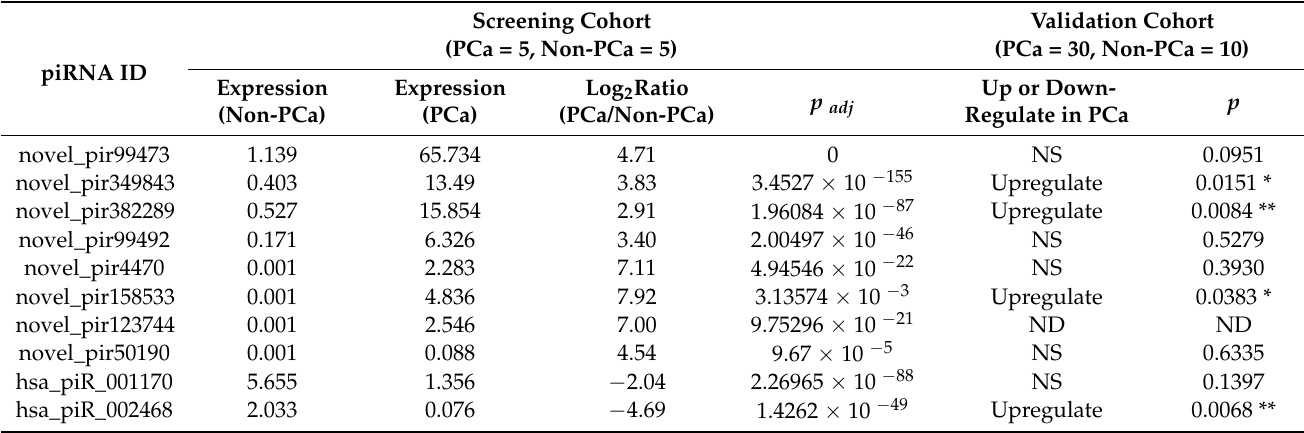
Table 2. Shortlisted piRNAs in screening cohort and validation